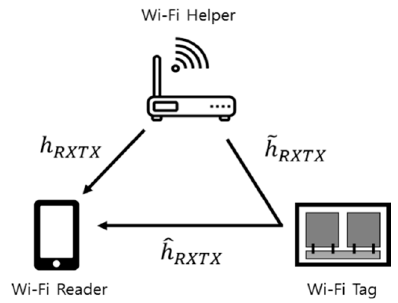
Figure 1. Configuration of the existing Wi-Fi backscatter communication system.